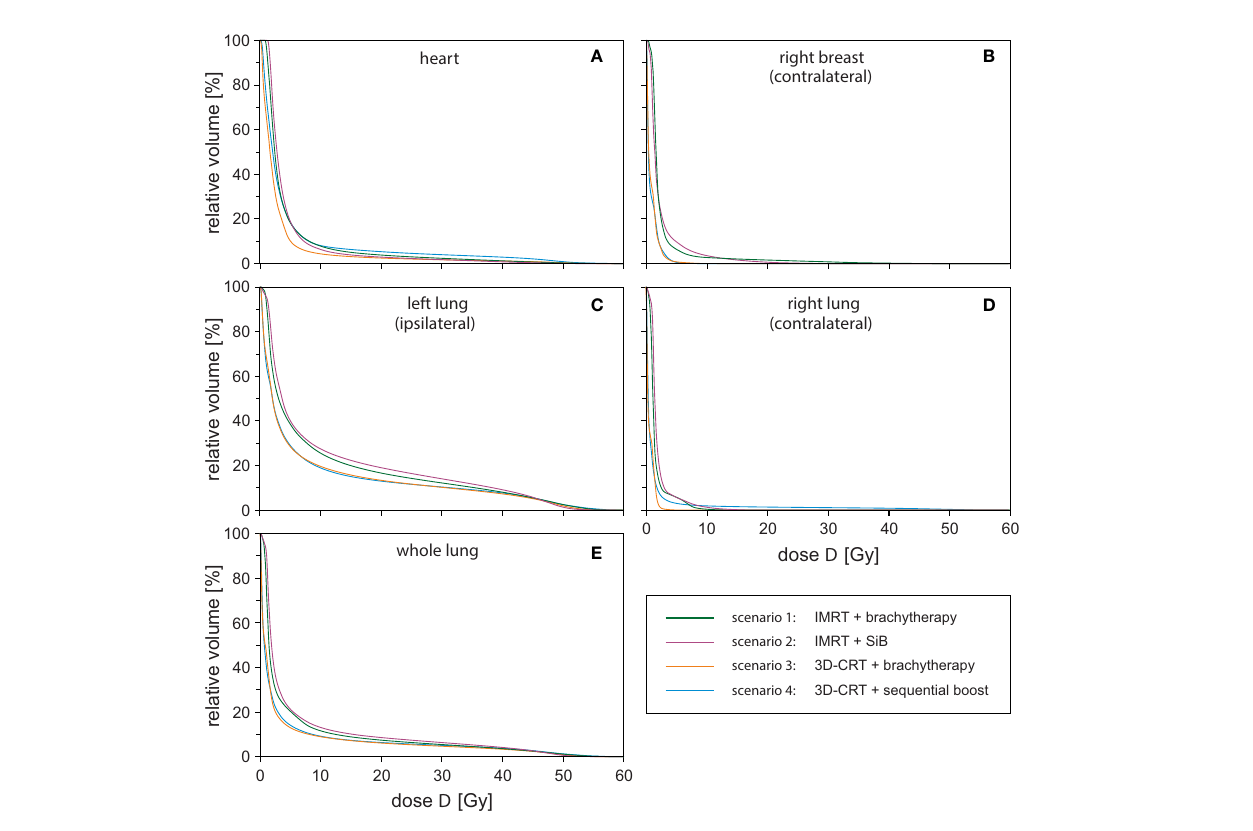
FIGURE 7 | Dose-volume-histograms for all investigated treatment techniques averaged over the respective sub-cohort and all regarded organs at risk: heart (A) , contralateral breast (B) , ipsilateral lung (C) , contralateral lung (D) , and whole lung (E)